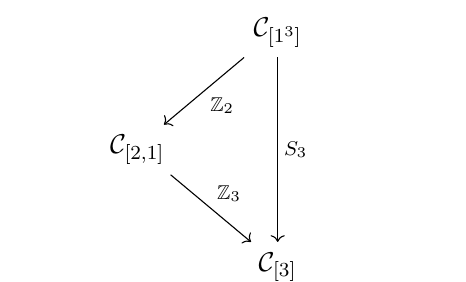
Figure 32 . Commutative diagram of Coulomb branch orbifold hierarchy for n = 3 ; k = 3 bou- quet quivers.